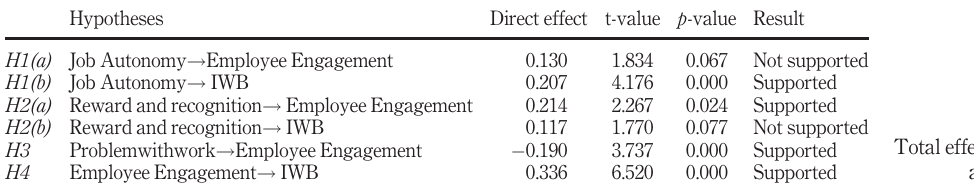
Table 4. Total effect, t -values